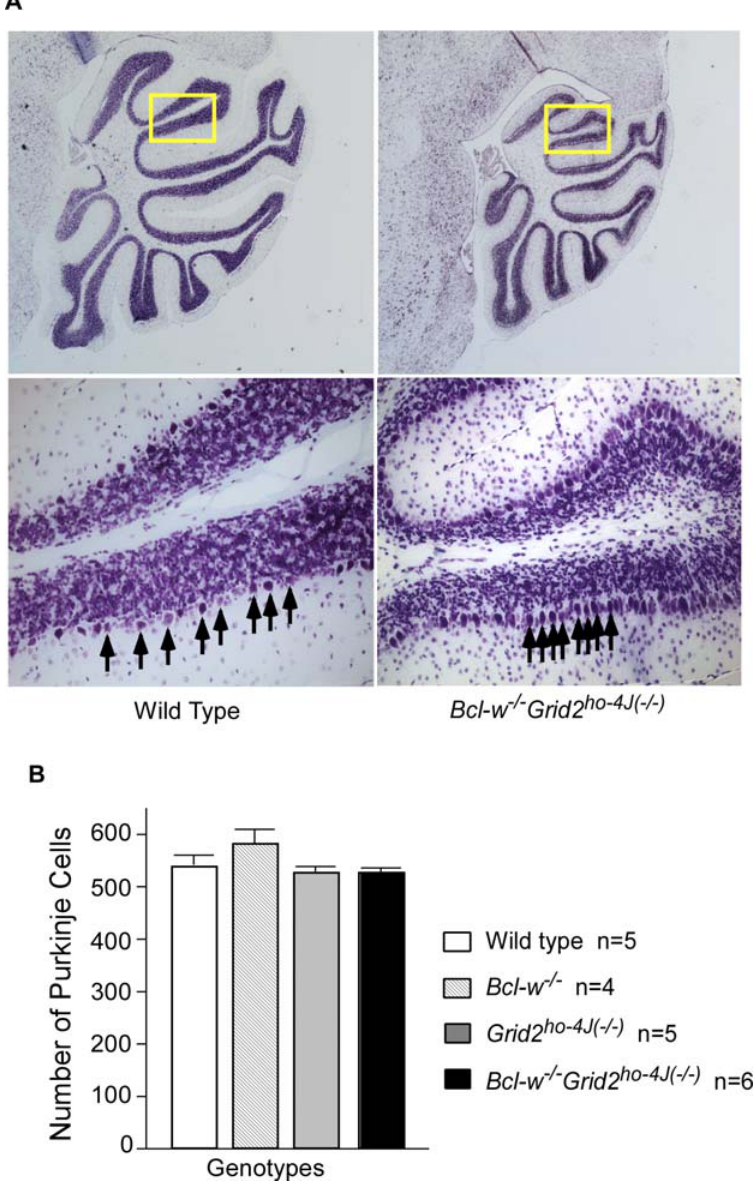
Figure 2. No Loss of Purkinje Cells in Bcl-w 2 / 2 ,Grid2 ho 2 4J( 2 / 2 ) or Bcl-w 2 / 2 Grid2 ho 2 4J( 2 / 2 ) Double Mutant Mice. (A) Nissil stain showing the smaller cerebellum (top panel) and overcrowded Purkinje cell layer (bottom panel) in a Bcl-w 2 / 2 Grid2 ho 2 4J( 2 / 2 ) double mutant mouse (right panels) relative to wild type mouse (left panels). (B) Bar graph demonstrating the average Purkinje cell numbers obtained from wild type, Bcl-w 2 / 2 , Grid2 ho 2 4J( 2 / 2 ) , and Bcl-w 2 / 2 Grid2 ho 2 4J( 2 / 2 ) mutant mice. Statistical analysis indicated no significant difference among Purkinje cell numbers of these genotypes. Error bars represent standard error of the mean.